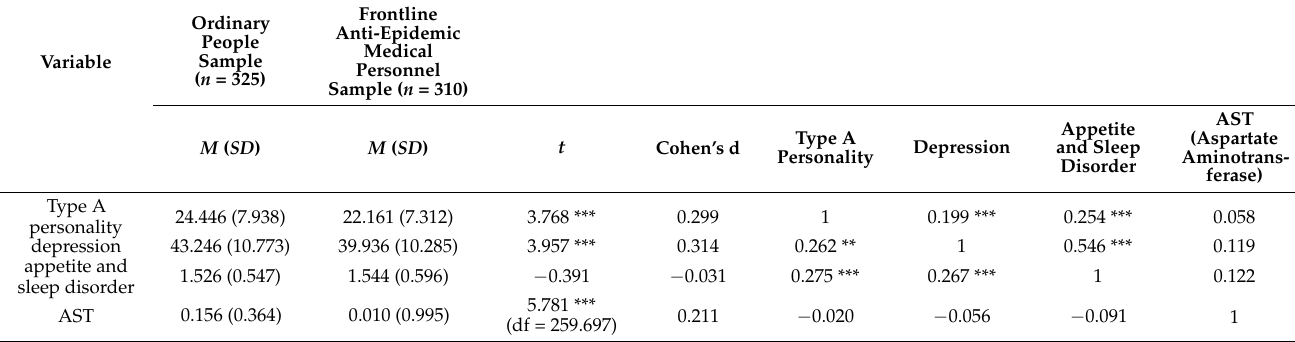
Table 1. Correlation coefficients and independent samples t -test.